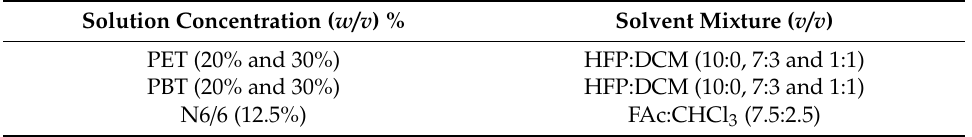
Table 1. Percentage of polymers used in the preparation of polymer solutions in di ff erent proportions in solvent mixtures.